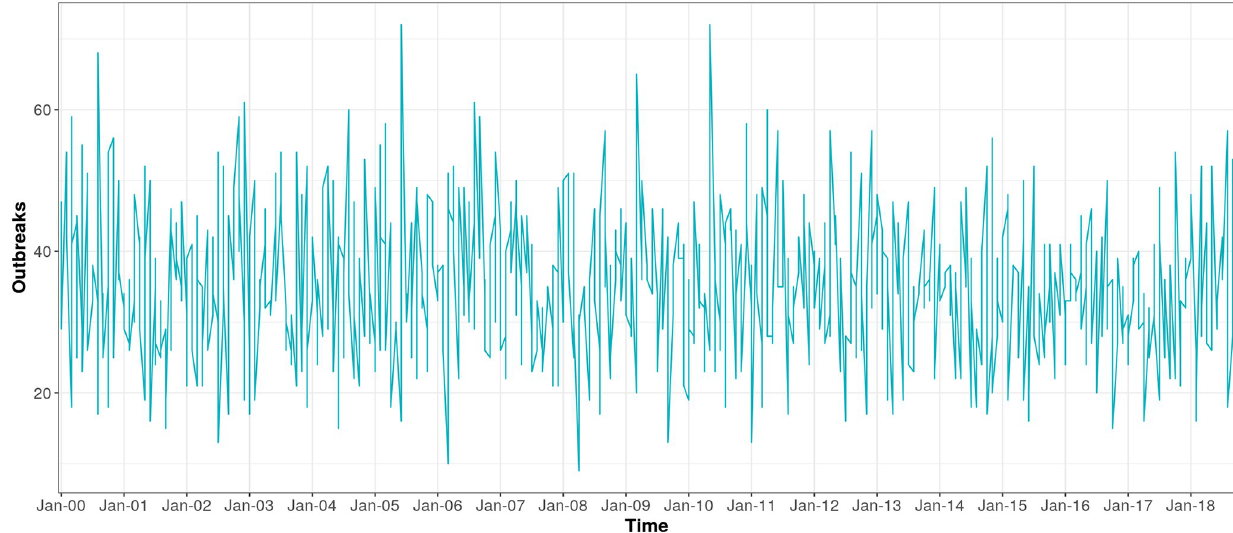
Fig 7. Number of outbreak weeks, summed over districts (n = 701), January 2000-September 2018.